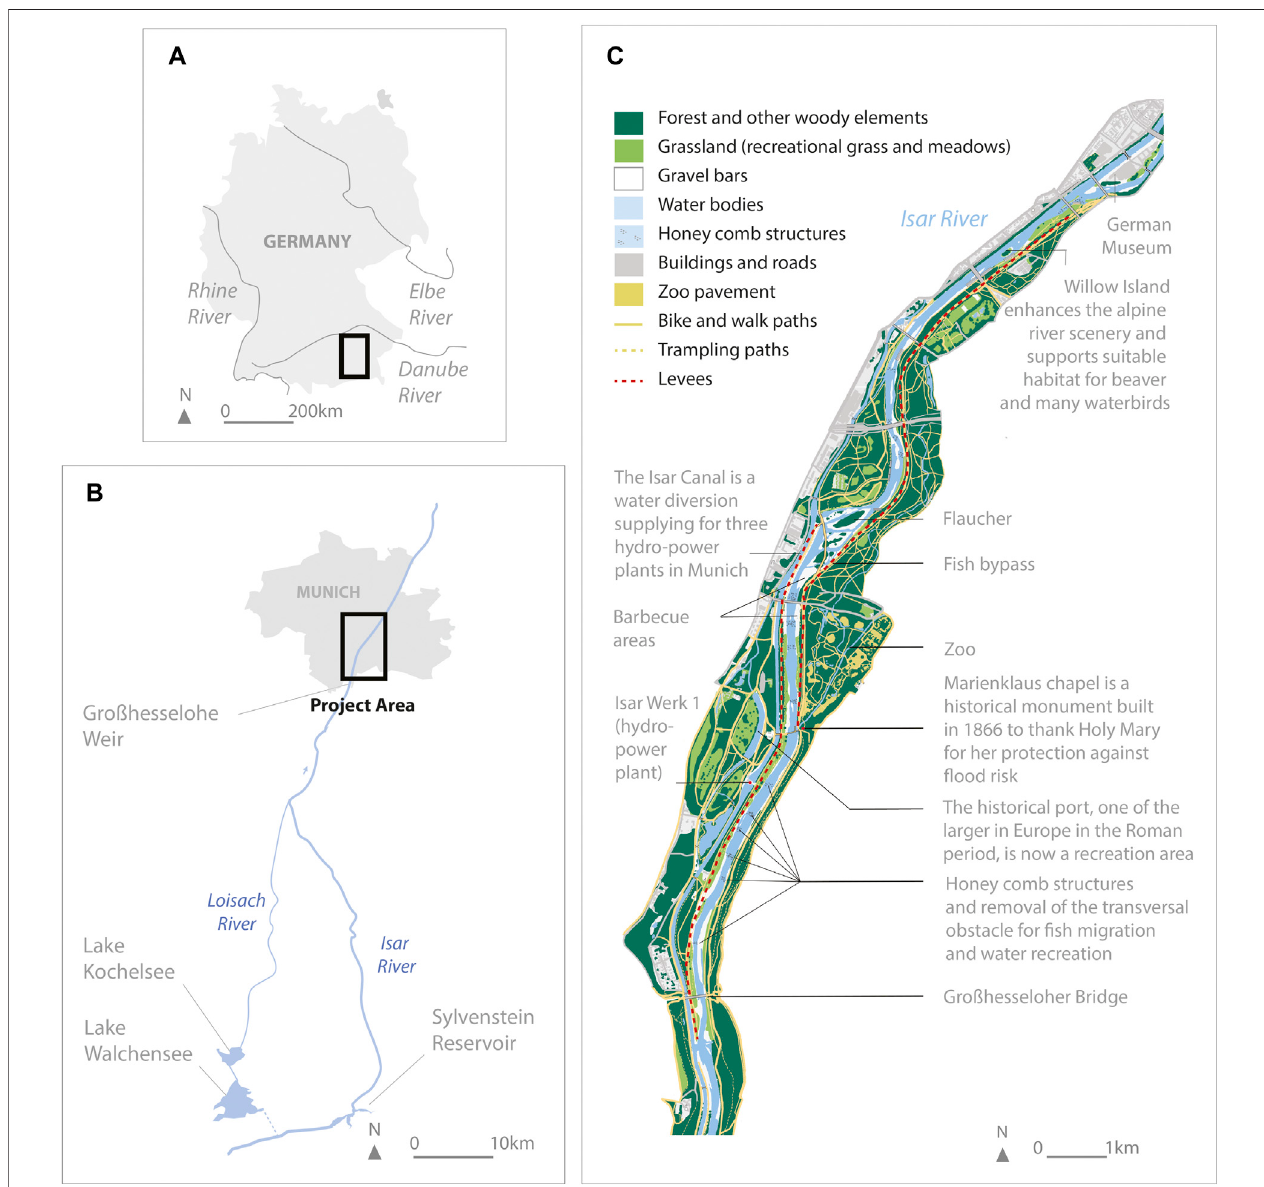
FIGURE 9 | Isar River Restoration Project in Munich, Germany. (A) Location Map, (B) Regional Map, and (C) Isar Restoration Project.